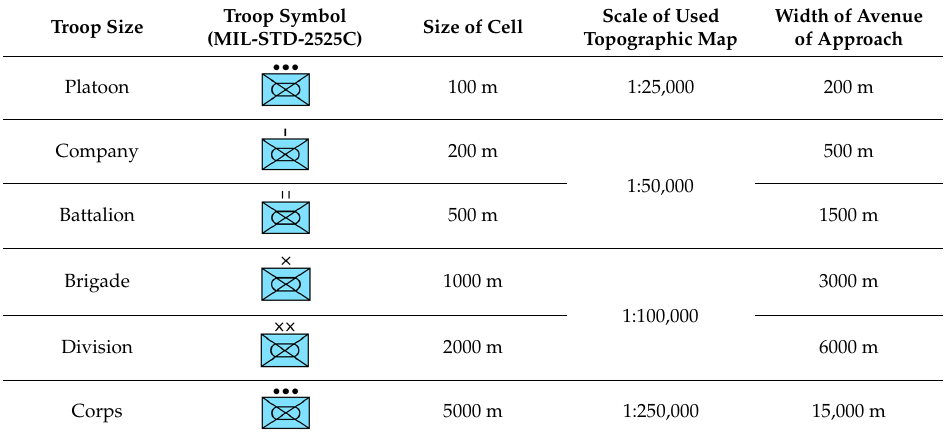
Table 3. Correlation between troop size, width of the avenue of approach, and the adopted cell size. Troop Size